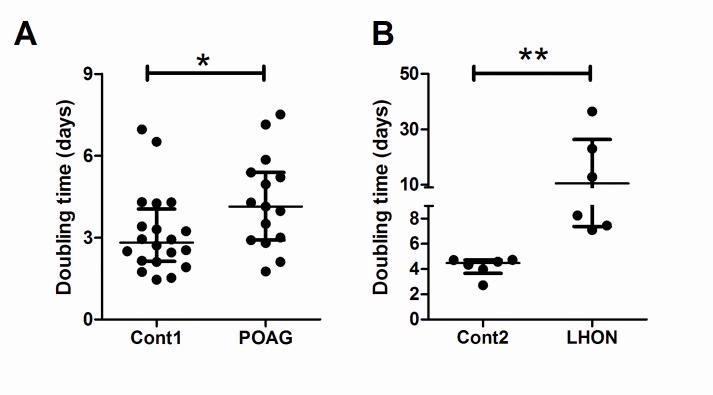
Impaired population doubling time in POAG and LHON lymphoblasts when forced to rely on OXPHOS.Control, POAG and LHON lymphoblasts were grown either in glucose media or galactose media, which forces cells to rely on OXPHOS for proliferation and survival. Proliferation curves were used to calculate population doubling time. A) POAG and B) LHON lymphoblasts had significantly longer population doubling time in galactose media when compared to controls. Data is median (IQR), Mann-Whitney test, n = 20 cont1, n = 15 POAG, n = 6 cont2 and n = 6 LHON, * = p< 0.05, ** = p< 0.01. Glucose media (RPMI-1640 media containing 2mg/ml glucose, 15% heat-inactivated serum, 2.05mM l-glutamine); Galactose media (glucose-free RPMI-1640 containing 5mM galactose, 4.5mM sodium pyruvate, 15% dialysed heat inactivated FBS, 2.05mM l-glutamine).